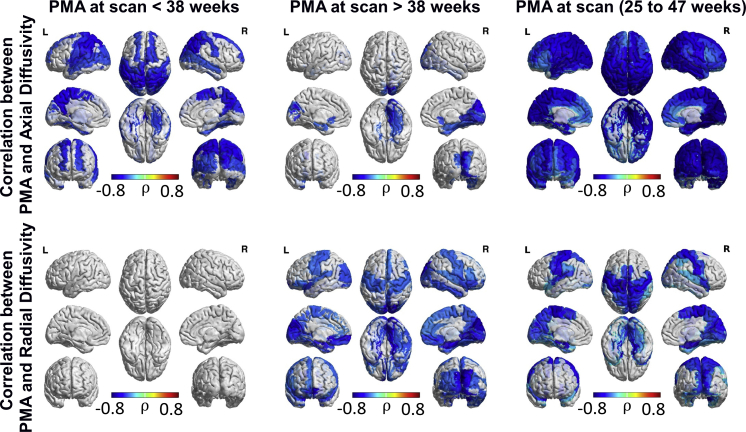
ROI-wise Spearman partial correlation between Axial and Radial diffusivity and postmenstrual age (PMA) at scan (FDR corrected at 5%).